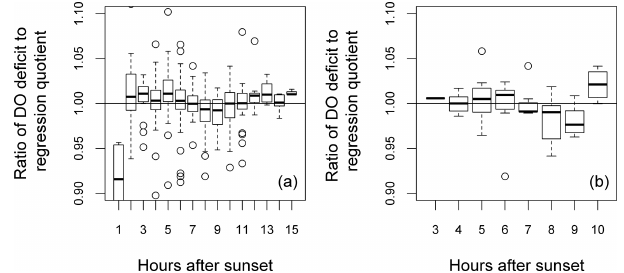
Figure 10. Relationship between time after sunset until the point of zero DO change and the ratio DOD zero (cid:49) DO : (regression quotient) for the river Wylye for the entire study period (a) and the 2-month period up to 20 May 2015 (b) . Hours after sunset are rounded to the nearest whole hour.